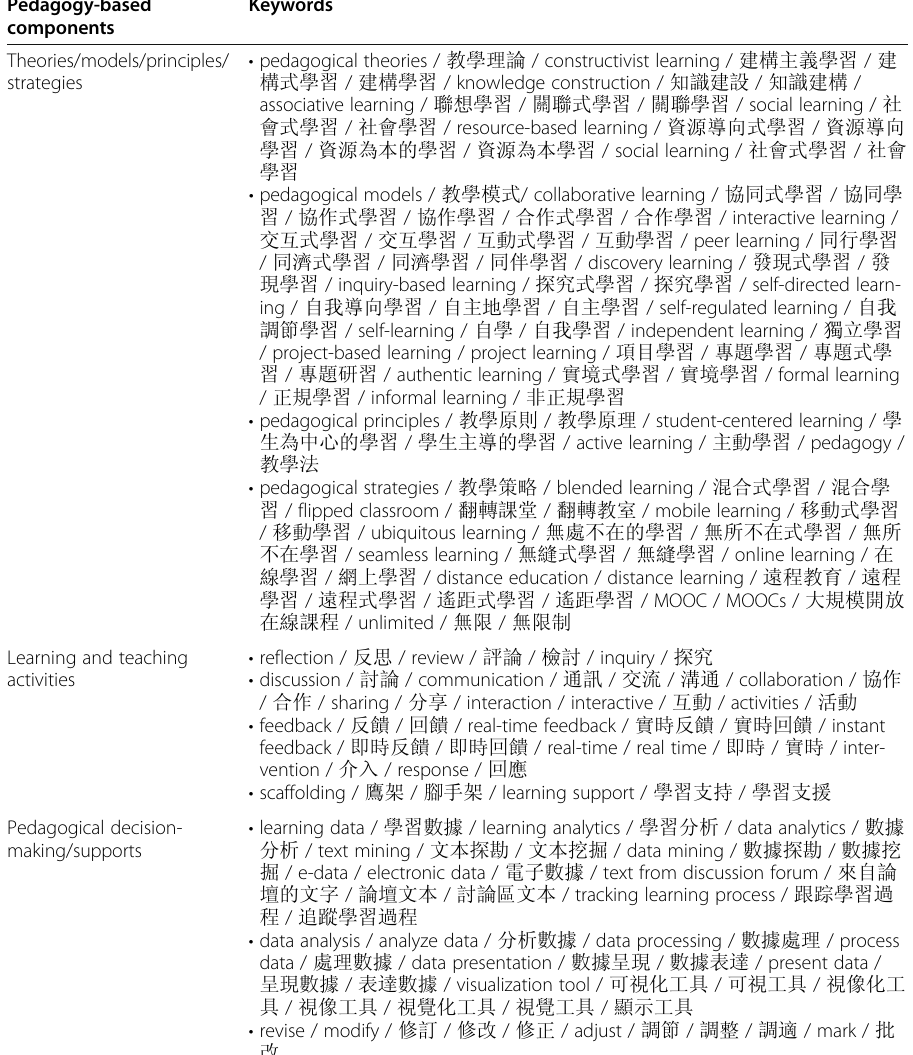
Table 2 Finalized keywords of this study on the pedagogy dimension of the proposed e-Learning framework Pedagogy-based components Theories/models/principles/